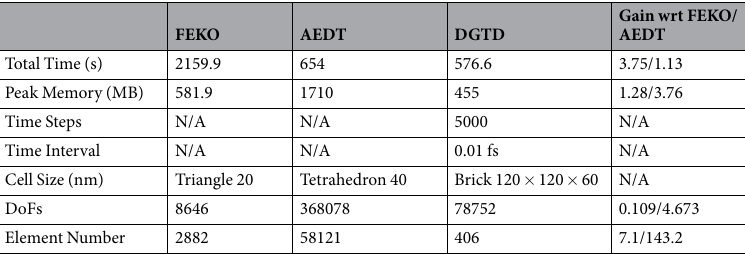
Table 2. Computational overhead comparison for the SRR case between the DGTD method, AEDT and